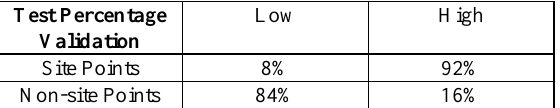
Table 3. Test Percentage Validation for site and non-site